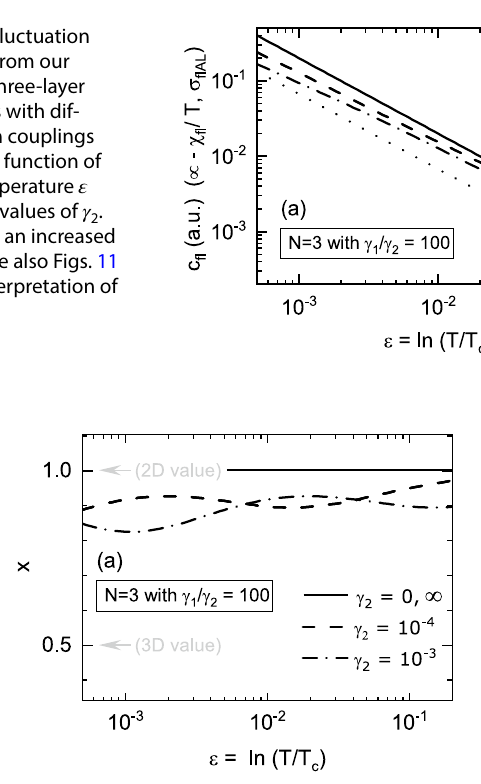
teaus) in Fig. 12 (see also main text). Panel b Same for an increased 𝛾 of the x ≠ 1 features